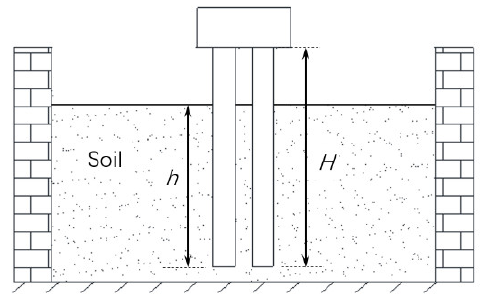
Figure 14. Changes to the pile buried depths in models P1 and P3.